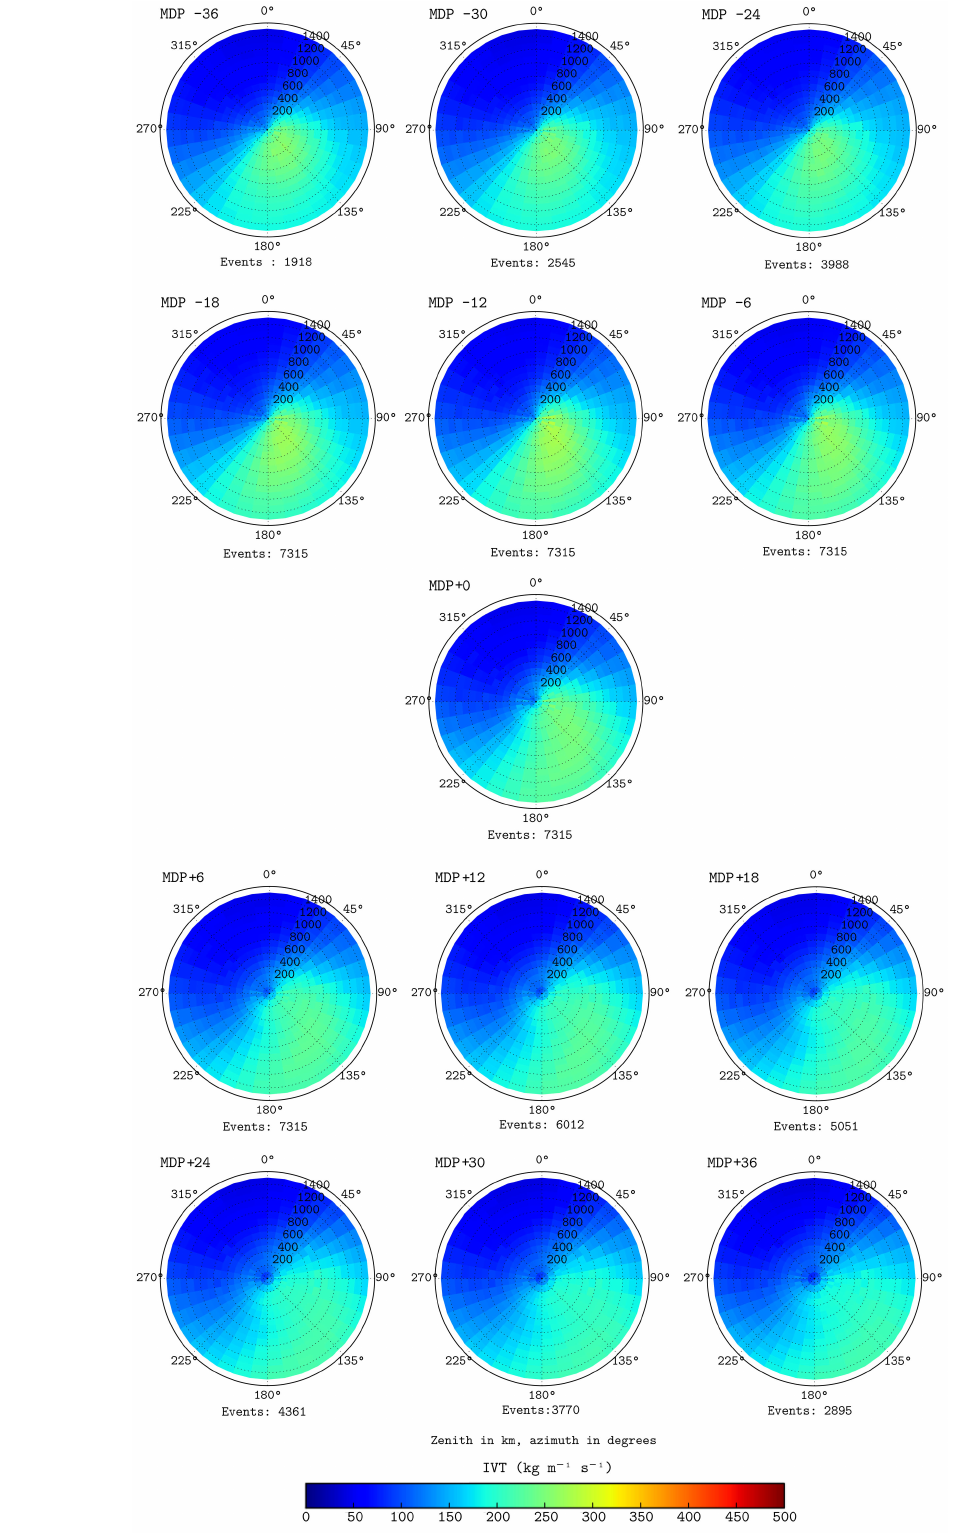
Figure 5. Same as Fig. 4 but for non-explosive cyclogenesis (NEC).